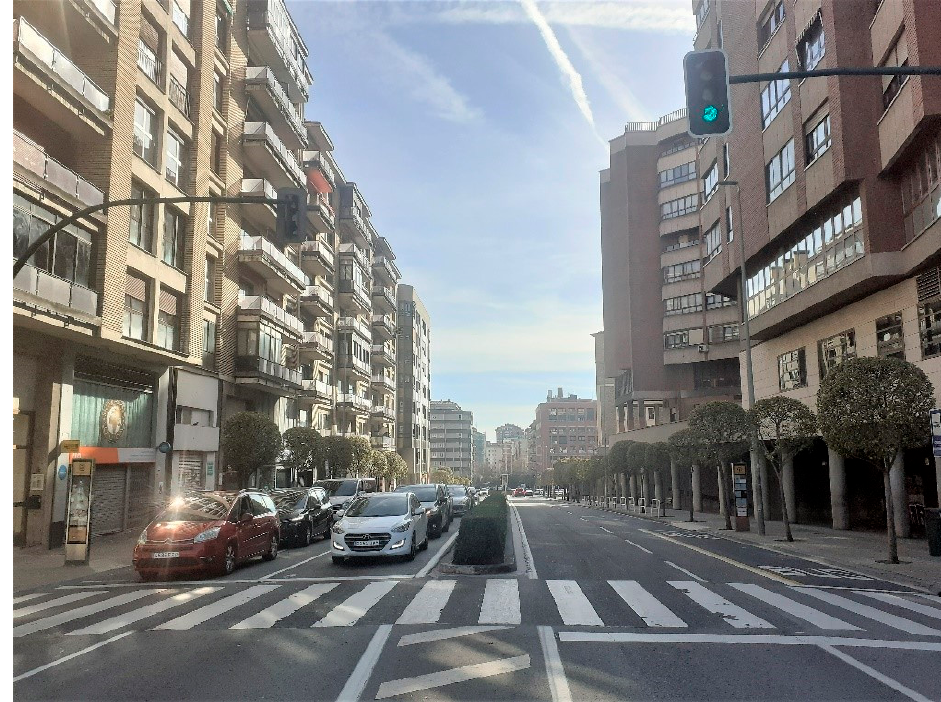
Figure 11. Zaragoza Avenue.